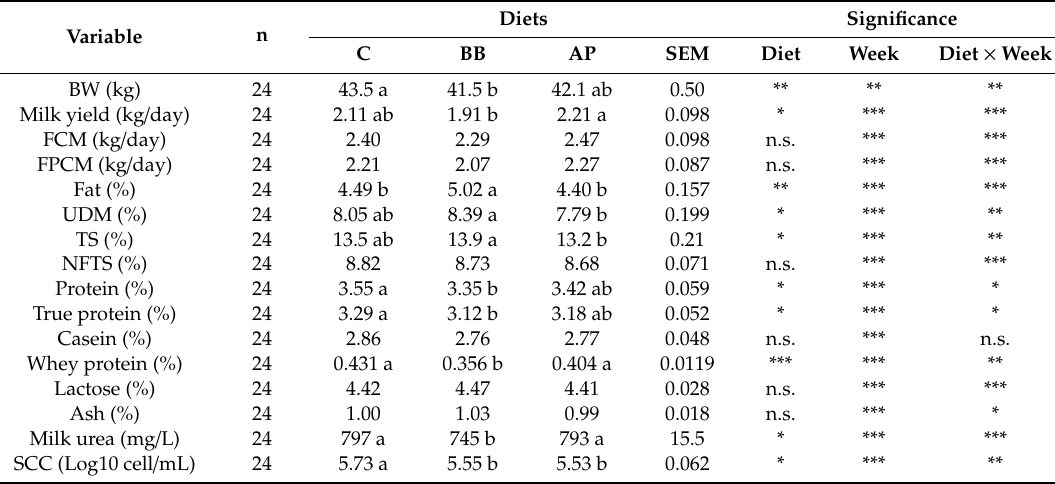
Table 3. Comparison of body weight, milk yield and composition and somatic cell count (SCC) in goat milk, according to the e ff ects considered from 7th to 27th lactation